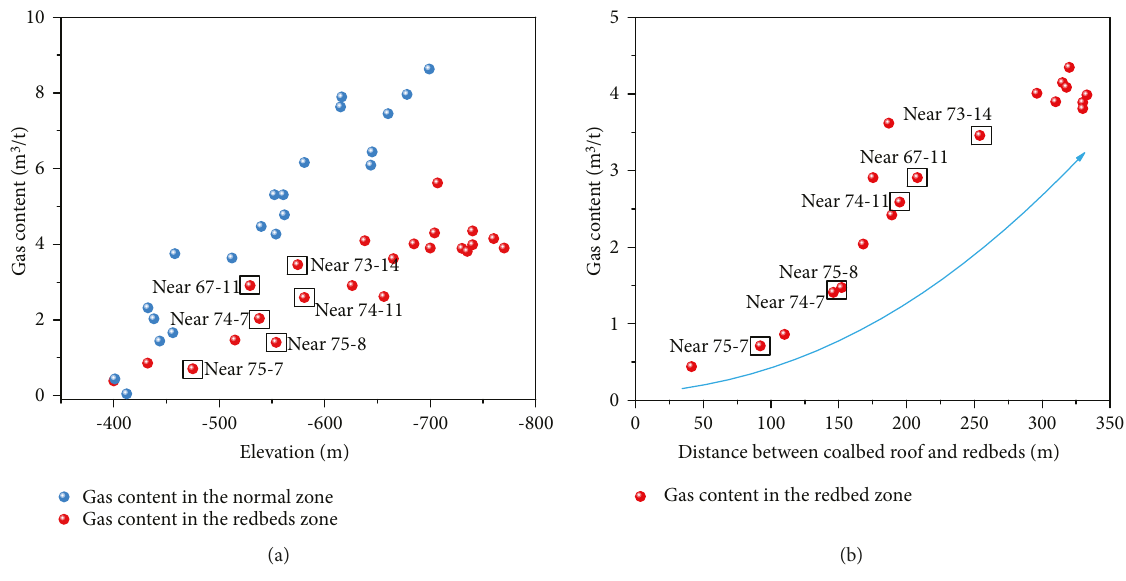
Figure 14: Veri fi cation of the in-place gas content in the fi eld: (a) relationship between gas content and elevation, and (b) relationship between gas content and caprock